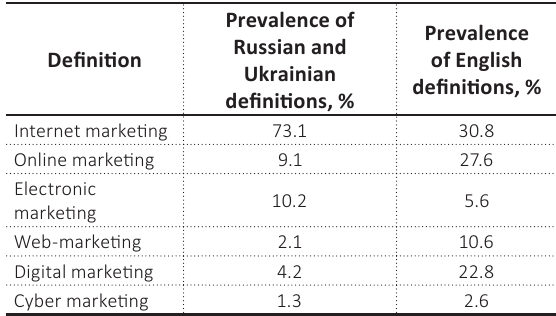
Table 1. The prevalence of basic